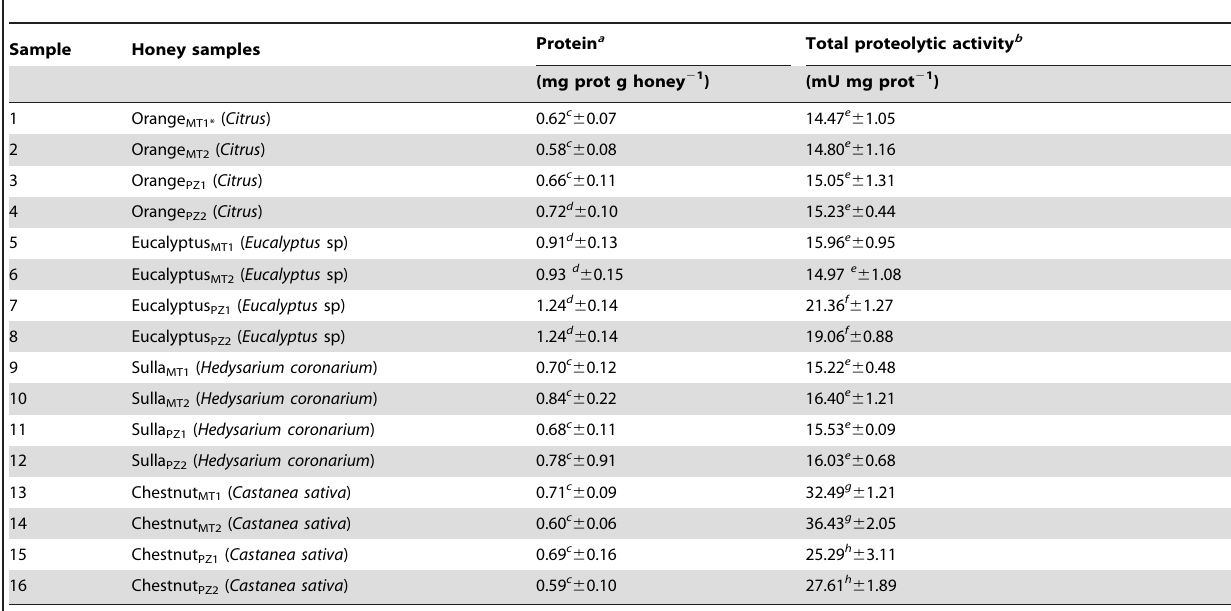
Table 1. Protein content and total proteolytic activity of honey samples of different floral origins.